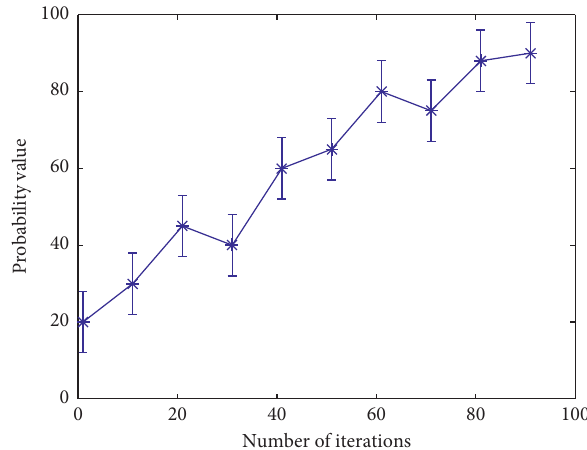
Figure 9: Classification accuracy error distribution of the deep learning feedback